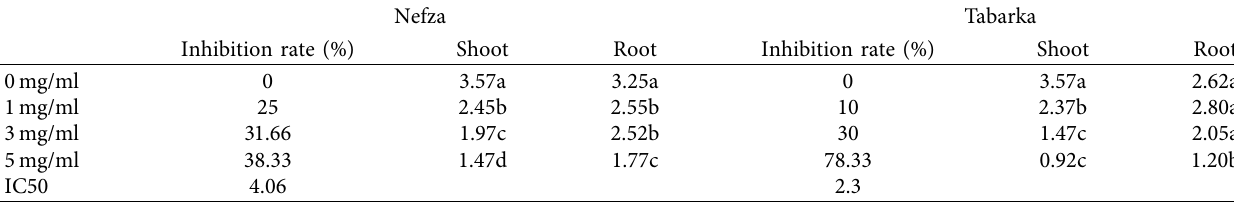
Table 9: Effect of ethanol extract on the germination of medicago seeds.